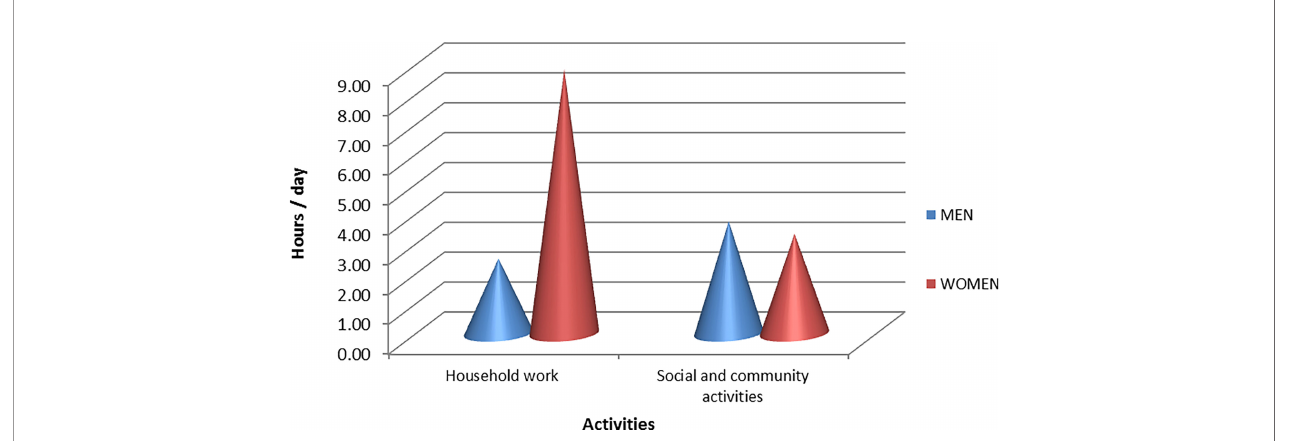
FIGURE 4 | Activity pro fi le (time spent) of men and women on reproductive, social, and community activities.